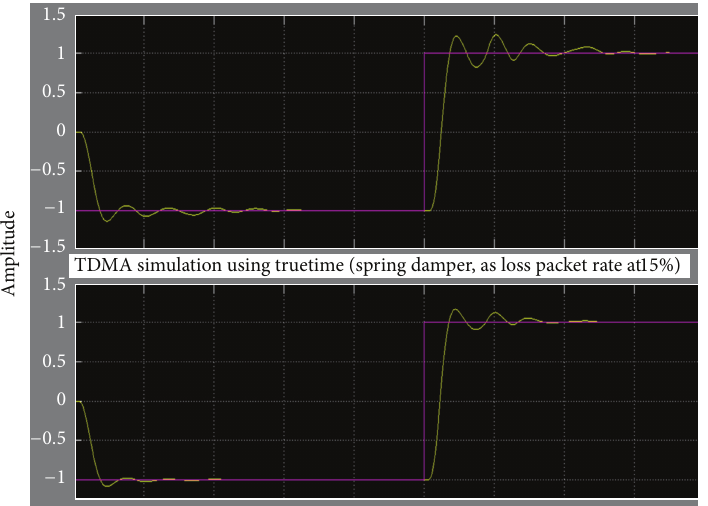
Figure 9: The relationship between loss packet rate and step response of spring damper.